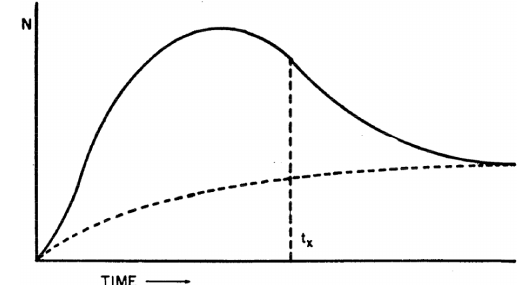
Figure 4. Expectations for rates of N accumulation with and with- out N fixers during primary succession. The solid line depicts high rates of N fixation (i.e., presence of legumes); the dashed line de- picts cases where fixers are absent from early successional sites (from Jenny,